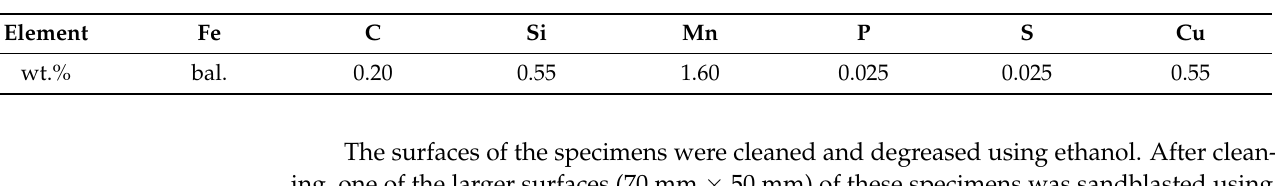
Table 1. Chemical composition of the substrate material S355 J2 plus N according to the material